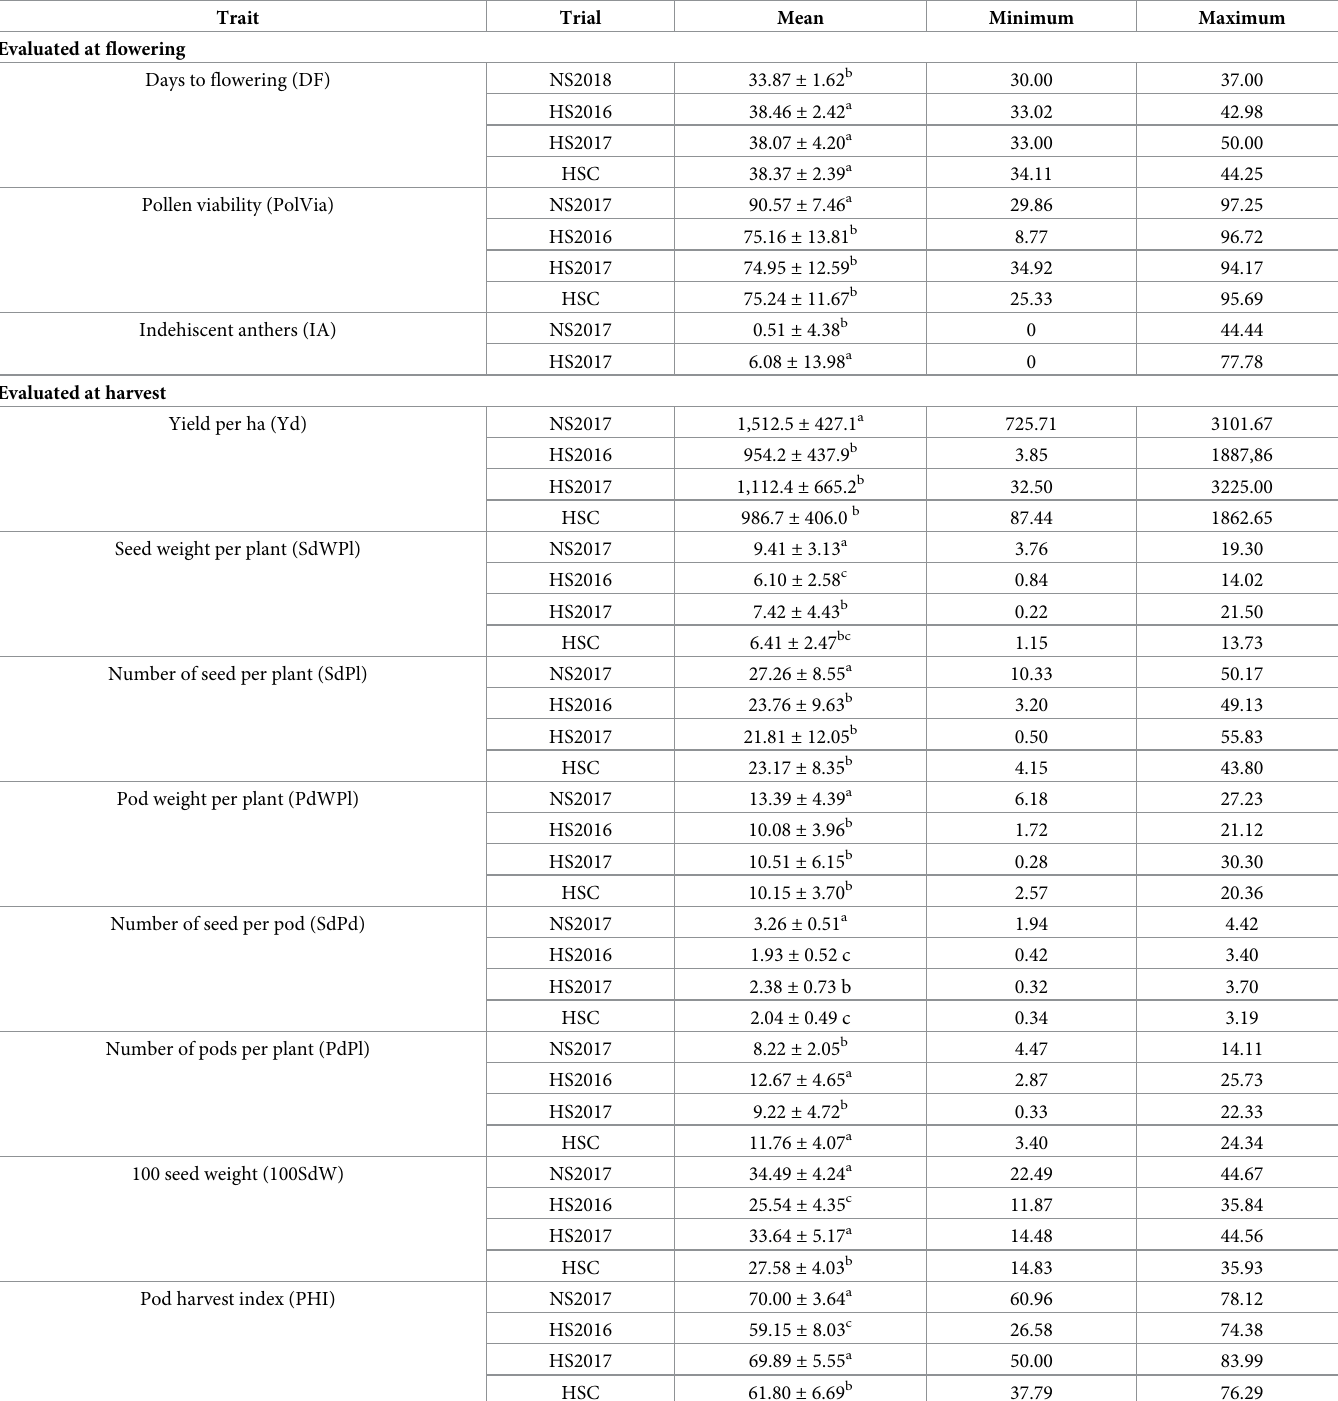
Table 1. Overview of phenotypic data of the IJR x AFR298 population evaluated in heat stress (HS) and non-stress (NS) trials.